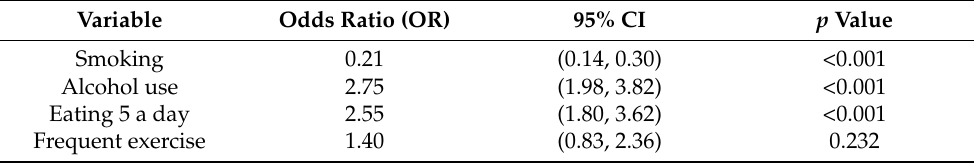
Table 2. Generalised estimating equation analyses adjusted for age and gender, showing odds ratios, 95% confidence intervals, and p values for the association between deprivation and heath behaviours. Variable Odds Ratio (OR) 95% CI p Value Smoking 0.21 (0.14, 0.30) <0.001 Alcohol use Frequent